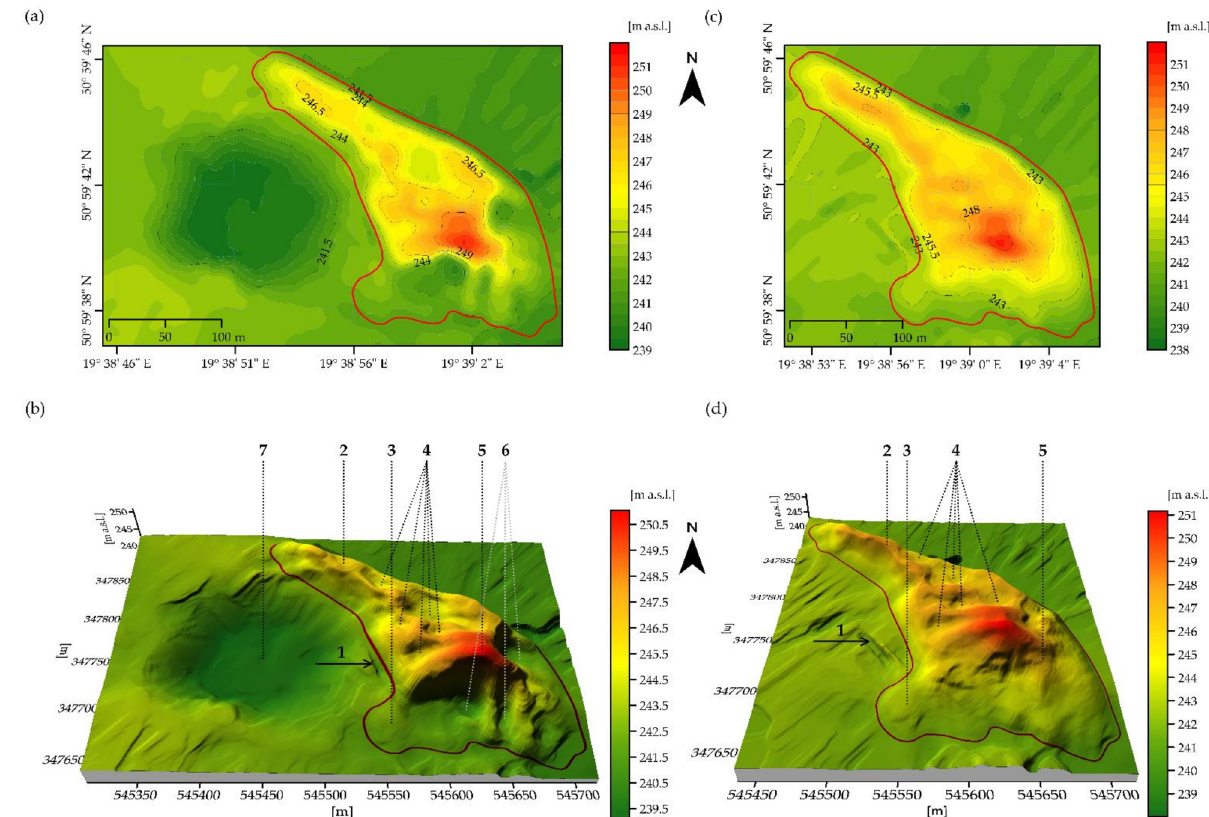
Figure 7. The reconstructed relief of the parabolic dune. Hypsometric map: ( a ) present relief; ( c ) primary relief; DEM with marked morphological elements of the dune: 1—dune migration/wind direction, 2—northern arm, 3—southern arm, 4—trough-like depressions, 5—crest, 6—anthropogenic pit (see also places marked in Figure 1 with the symbols A, B, and C), 7—blowout: ( b ) present relief, ( d ) primary